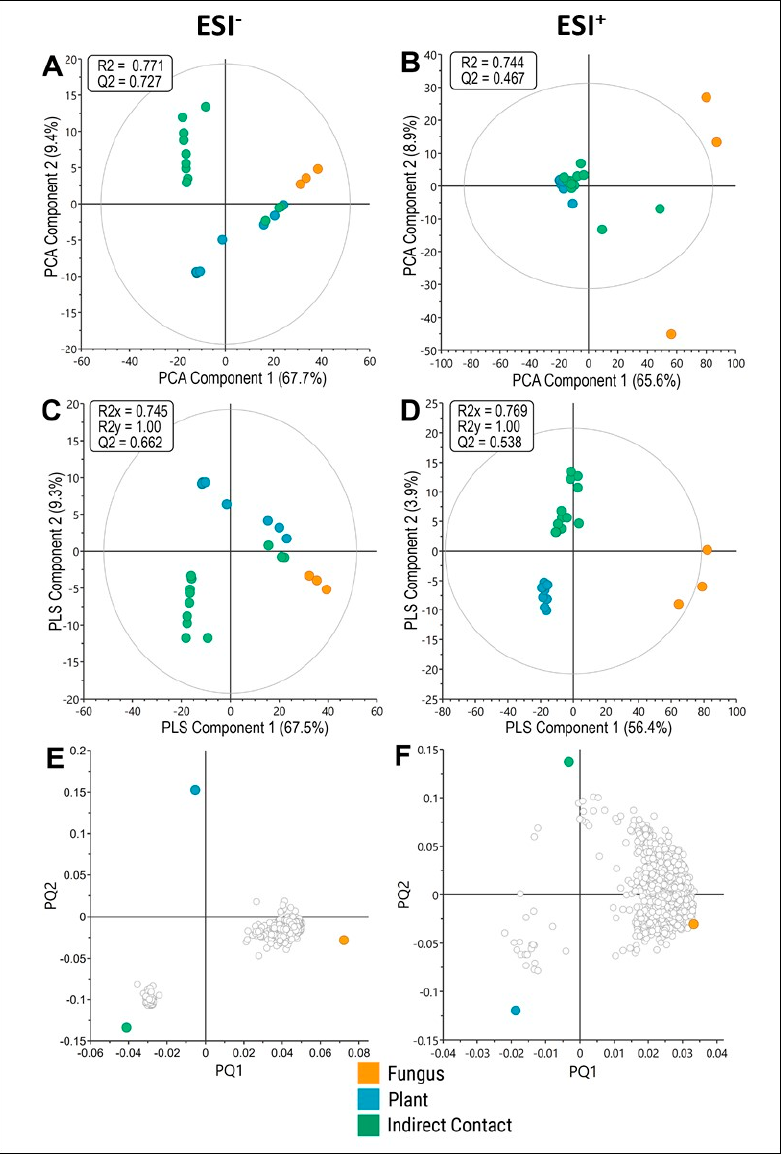
Figure 3. Multivariate analysis of metabolomic data sets. ( A , B ) PCA score plots for ESI- ( A ) and ESI+ ( B ) mode data, showing the first two components of metabolite profiles. ( C , D ) OPLS-DA score plots for ESI- ( C ) and ESI+ ( D ) mode data, showing the first two components of a supervised classification model and separation of metabolite profiles. ( E , F ) Loading plots derived from OPLS-DA of 560 ESI- mode features ( E ) or 1530 ESI+ mode features ( F ). Conditions are indicated in colours: fungus-only (orange), plant-only (blue), and indirect contact (green). Features were sampled at 48 h after start of